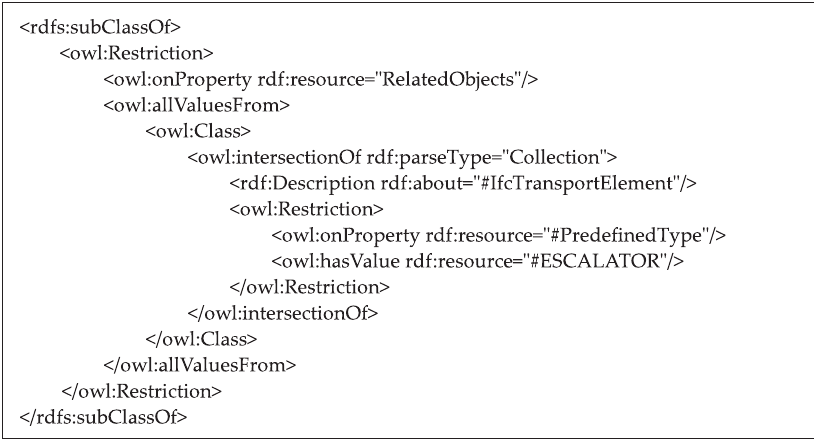
Figure 13: The restriction of RelatedObject in IfcRelEscalator.